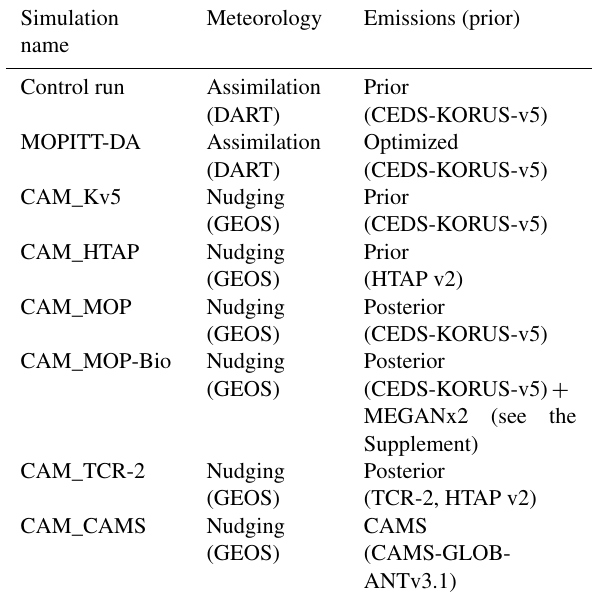
Table 2. Summary of the simulations. The nudging (GEOS) refers to a CAM-Chem deterministic runs with specified dynamics using a nudging to GEOS-FP analysis winds and temperatures (see the Sup- plement). Aside from the DART simulations (first two rows), all the simulations have the same initial conditions and the same nudging and only change by their anthropogenic CO emissions inputs.